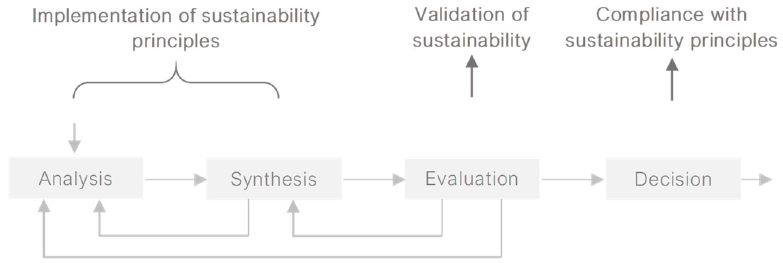
Figure 1. Decision-making process to implement sustainability. Source: [34] (adapted).